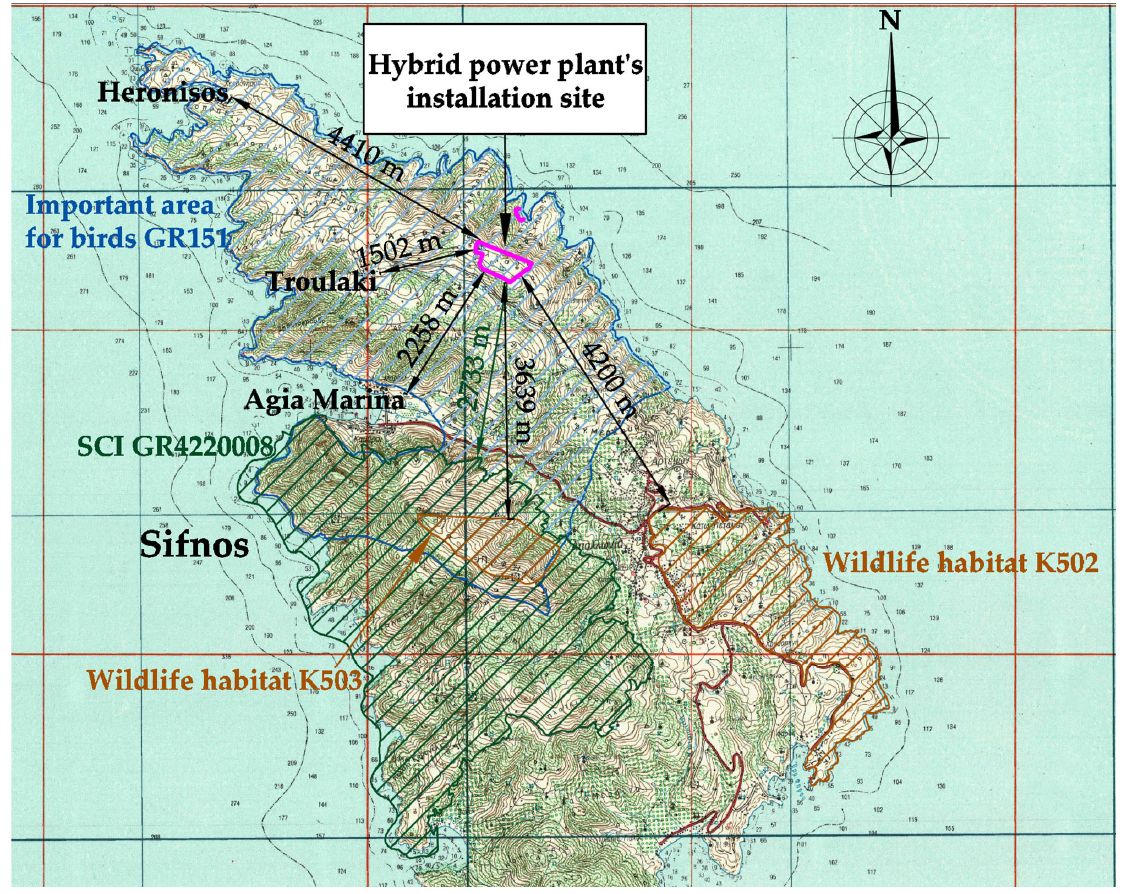
Figure 12. Distance of the hybrid power plant’s installation site from the points of interest on the